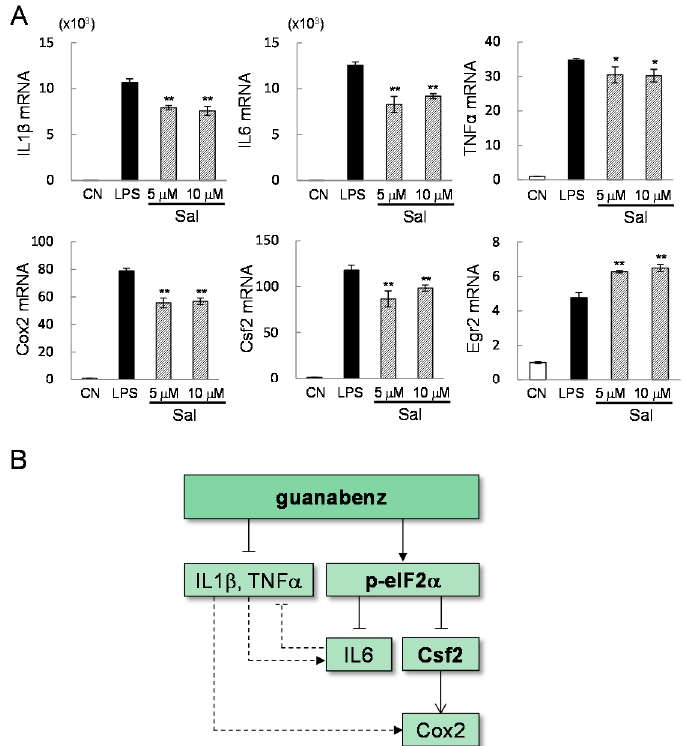
Figure 8. ( A ) Effects of salubrinal on the mRNA levels of the selected genes (IL1 β , IL6, TNF α , Cox2, Csf2, and Egr2) in LPS-stimulated RAW264.7 cells. The single and double asterisks indicate p < 0.05 and p < 0.01, respectively; ( B ) Schematic mechanism of guanabenz-driven regulation of inflammatory genes. The solid line is based on the result in this study, while the dotted line is from other studies.